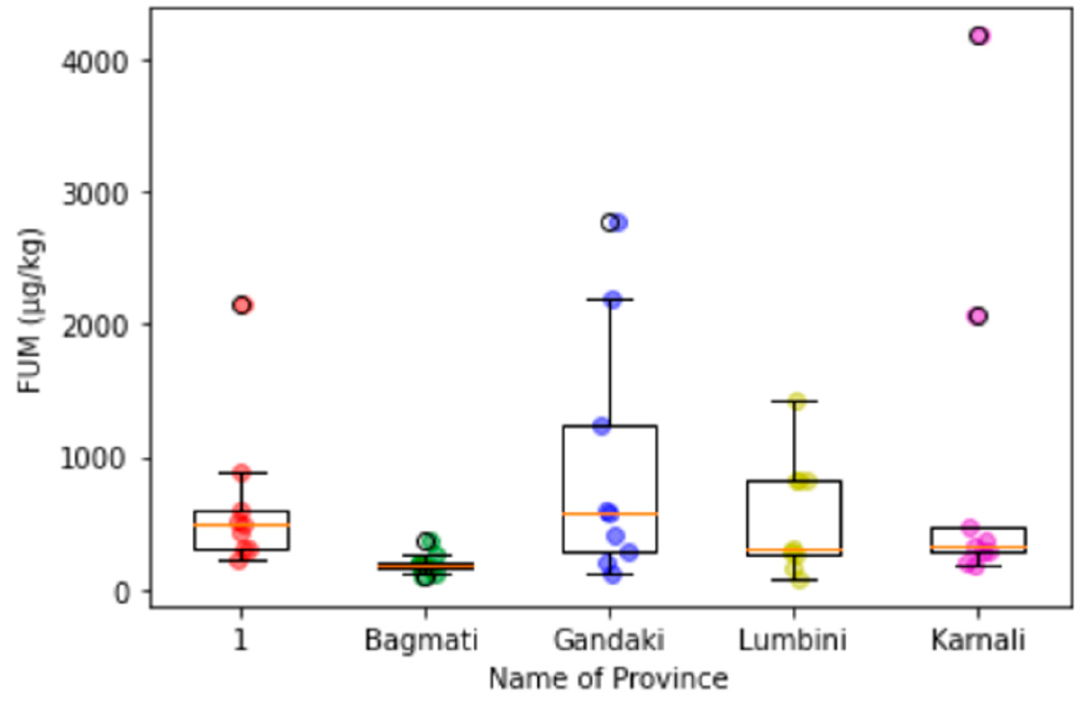
Figure A10. Contamination level of FUM.